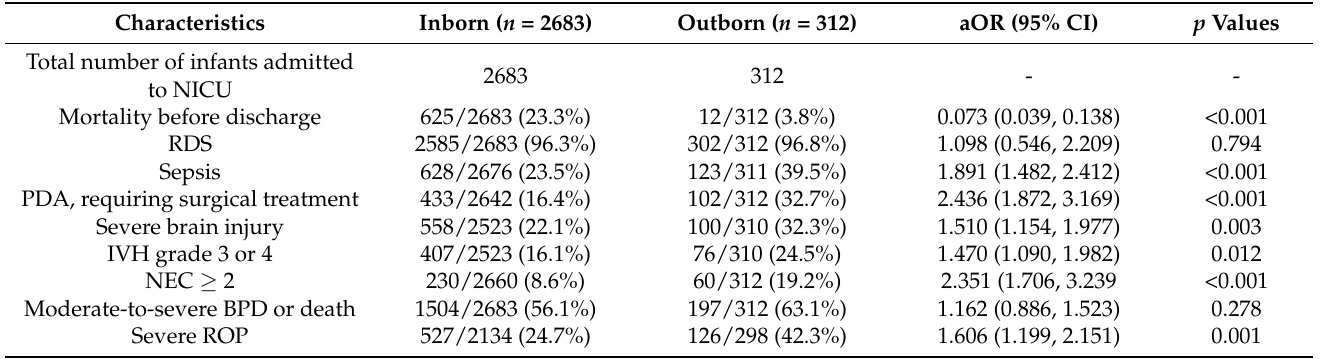
Table 2. The short-term neonatal